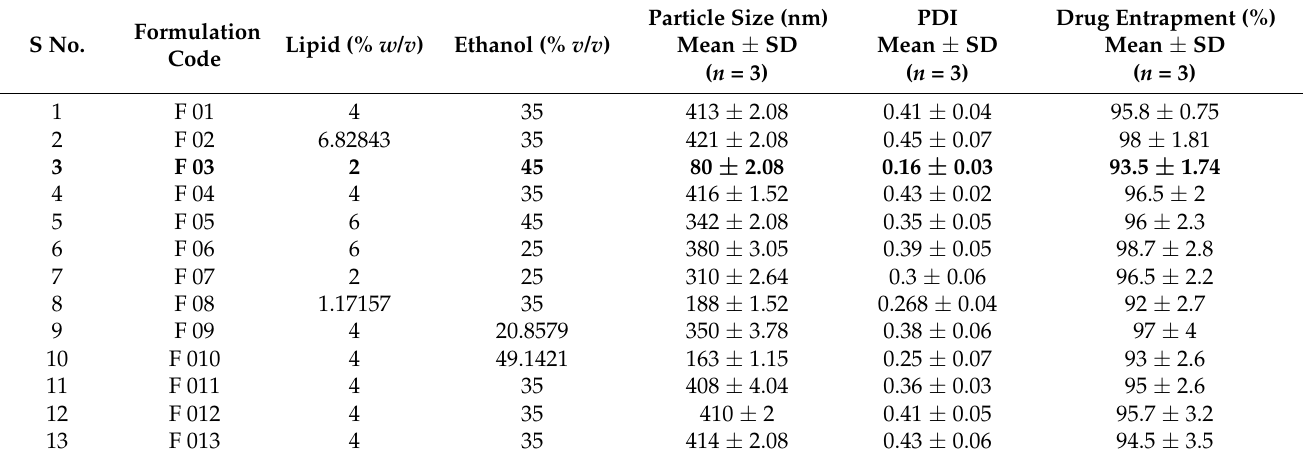
Table 6. Formulation runs with dependent variable responses. These are generated by Design of Expert depicting predicted particle size, PDI and drug